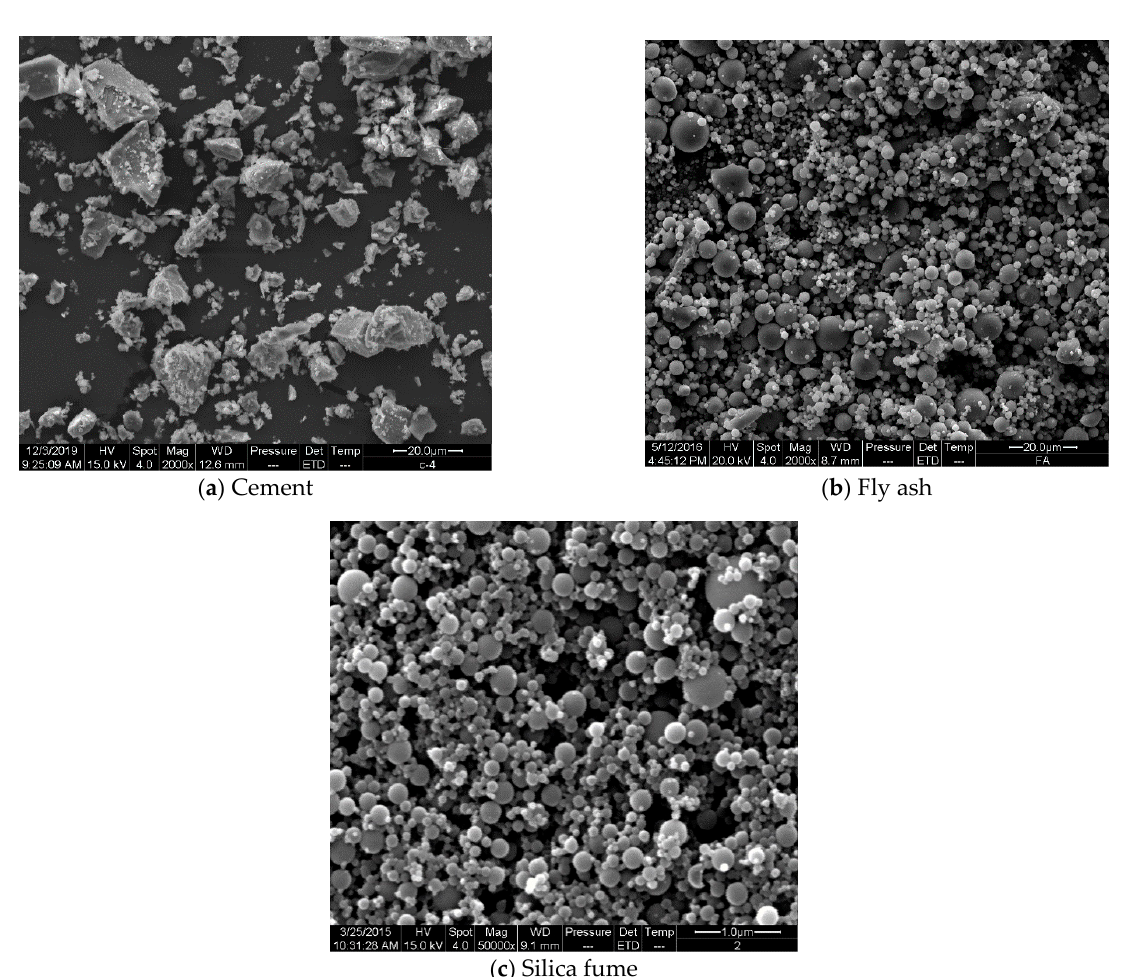
Figure 2. Particle morphology of the three cementitious materials. ( a ) Particle morphology of Cement; ( b ) Particle morphology of FA; ( c ) Particle morphology of SF.